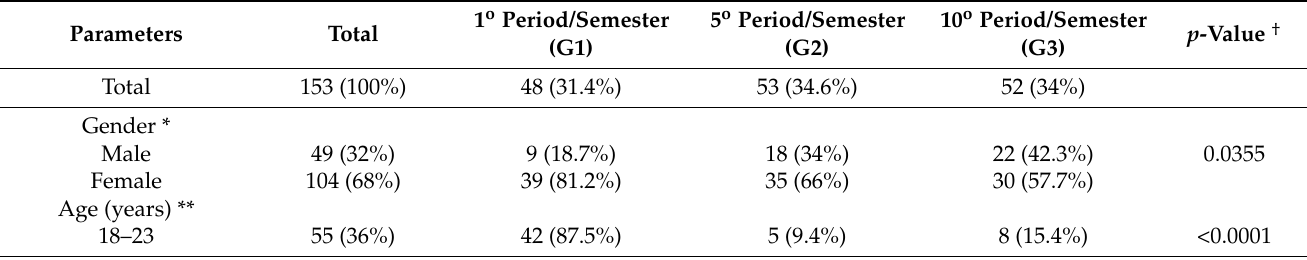
Table 1. Socioepidemiological data and general knowledge about cardiac patient management of DUS in 3 different periods/semesters in dentistry